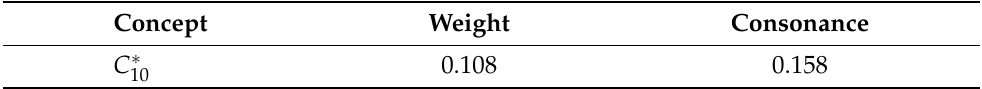
Table 8. Vector of positive–negative changes in concept C 10 with minimal adjustments.